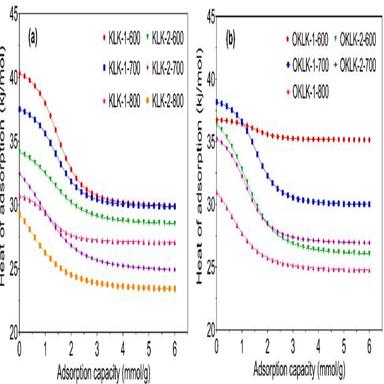
Isosteric heat of CO2 adsorption calculated from the adsorption isotherms at 0 and 25 ◦C for (a) KLK carbons; (b) OKLK carbons.